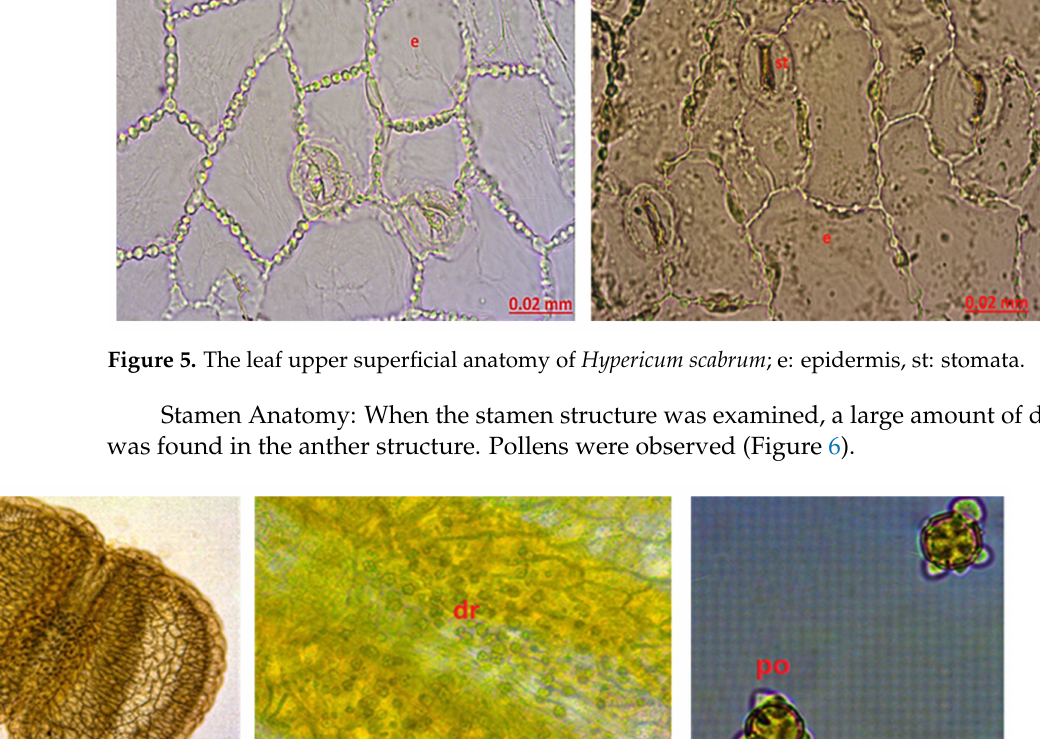
glandular projections is oval-shaped and yellow-orange in color. Xylems are prominently blue with Sartur reagent were found (Figure